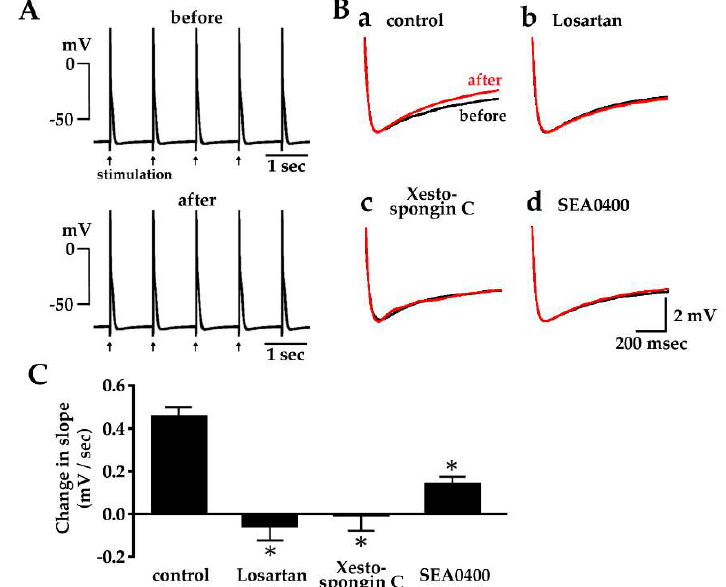
Figure 5. Enhancement of diastolic depolarization by angiotensin II under constant firing frequency.